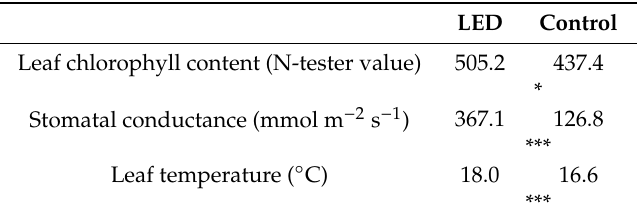
Table 2. E ff ect of lighting regime on leaf chlorophyll content, stomatal conductance, and leaf temperature in spring